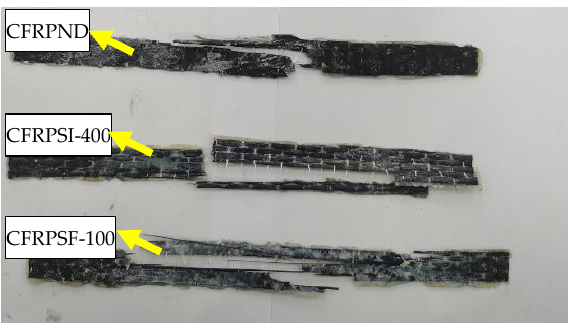
Figure 15. Failure mode of CFRP sheet.